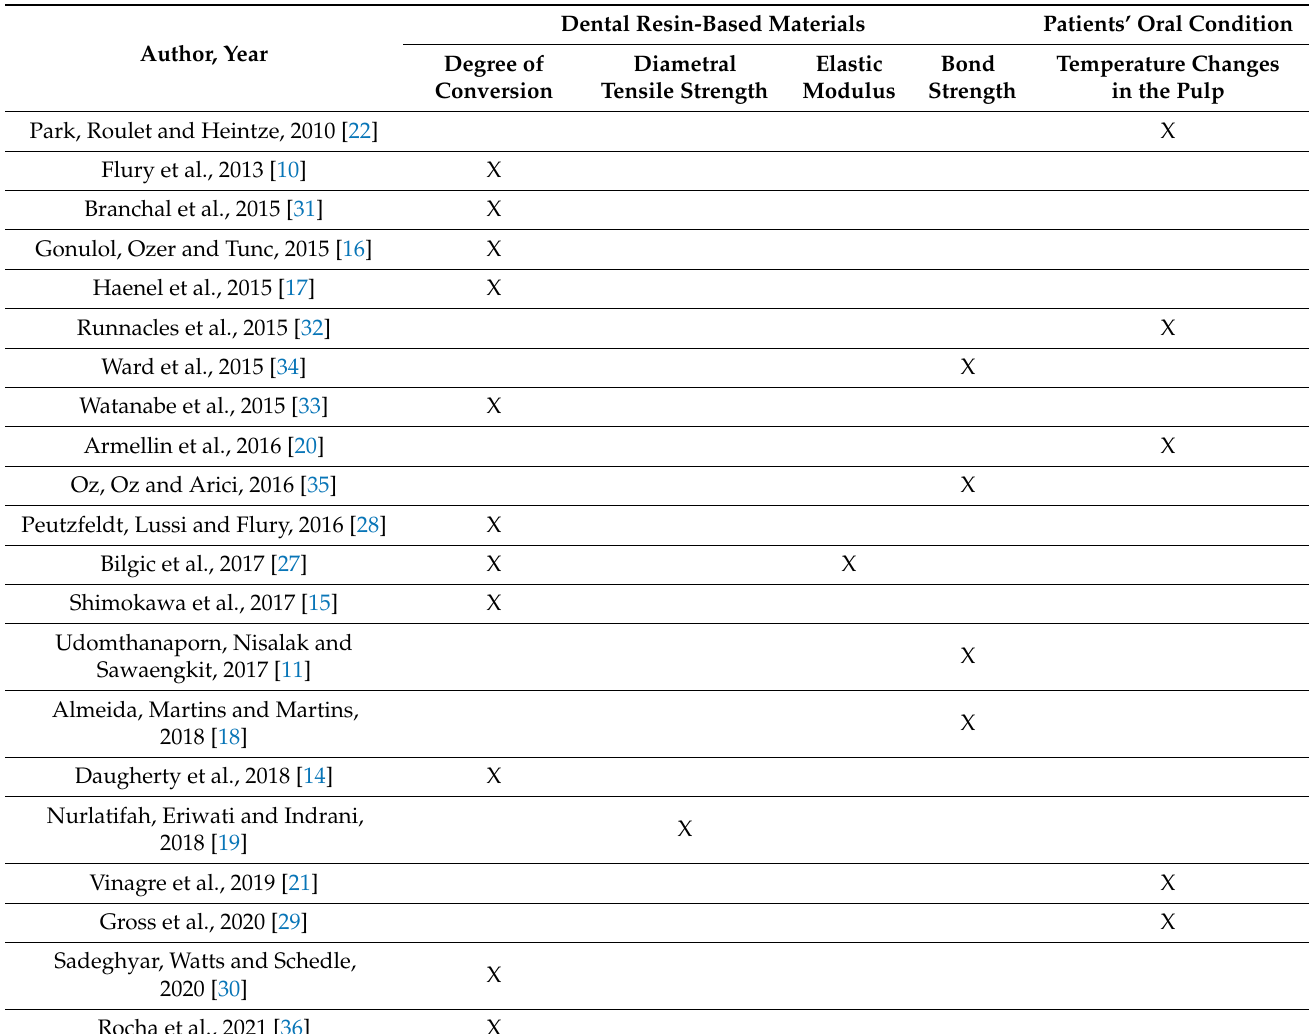
Table 5. Summary of the main adverse events described on dental resin-based materials and on patients’ oral condition.